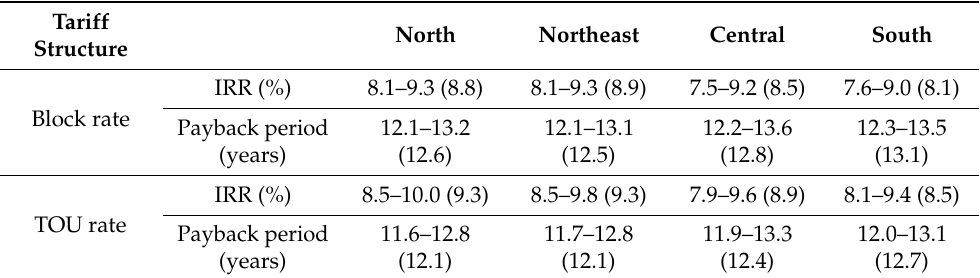
Table A8. IRR and payback period by region for residential customers under a block rate and